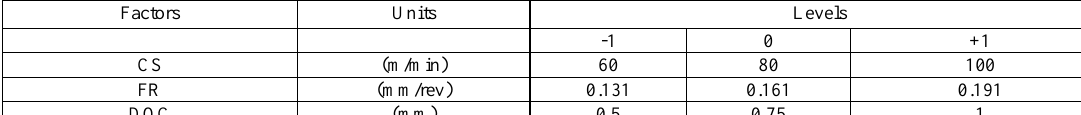
Table 2. Chosen varying cutting conditions and levels